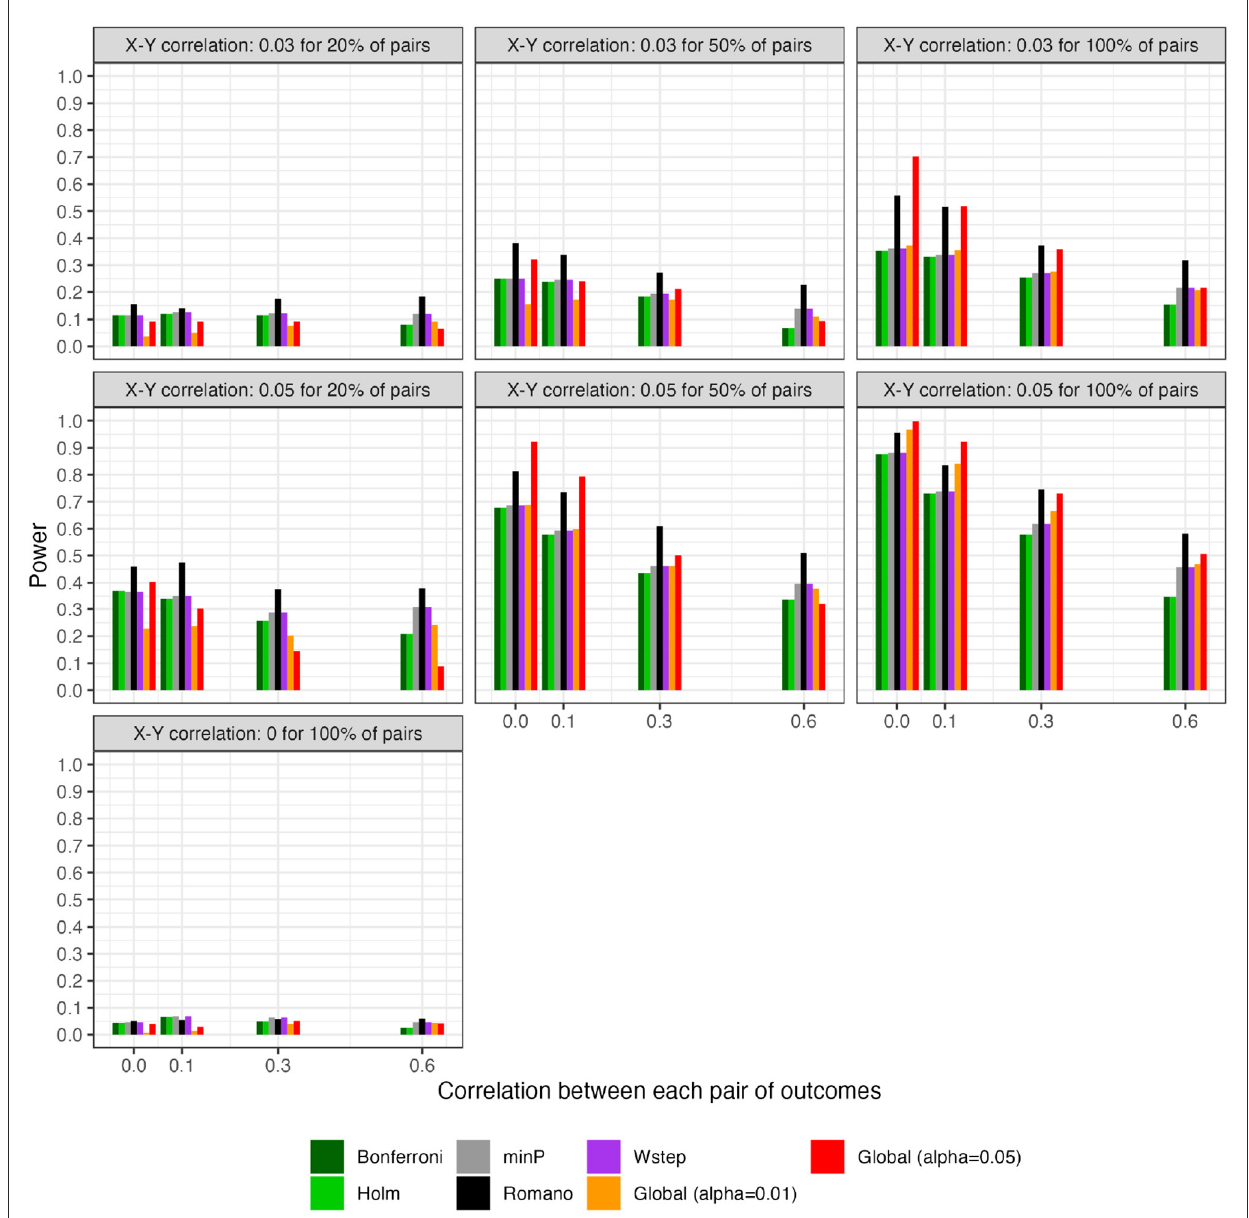
FIGURE3 For scenarios with 40 outcomes, power or Type I error of global tests based on existing FWER-control procedures and on the number of rejections. “Global (alpha = 0.01)” and “Global (alpha = 0.05)”: proposed methods. The final panel represents Type I error under the global null.